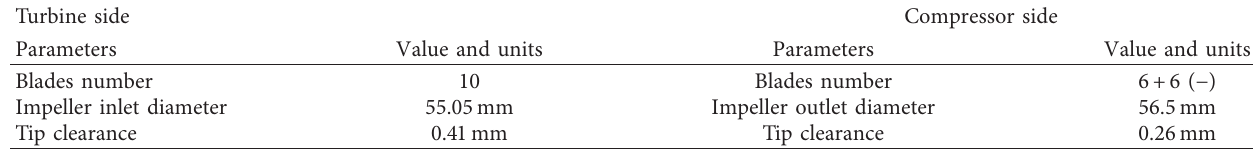
Table 1: Turbocharger and compressor parameters.